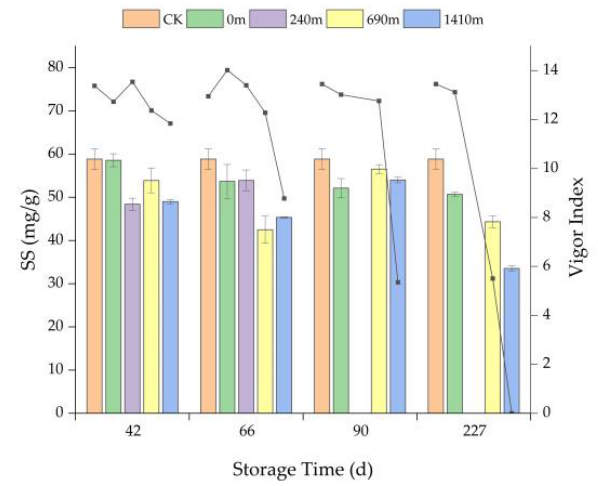
Figure 4. Variation of SS content of rapeseed seeds stored in deep underground with storage duration and depth. The bar graph showed the variation of SS content, and the line graph showed the variation of vigor index.